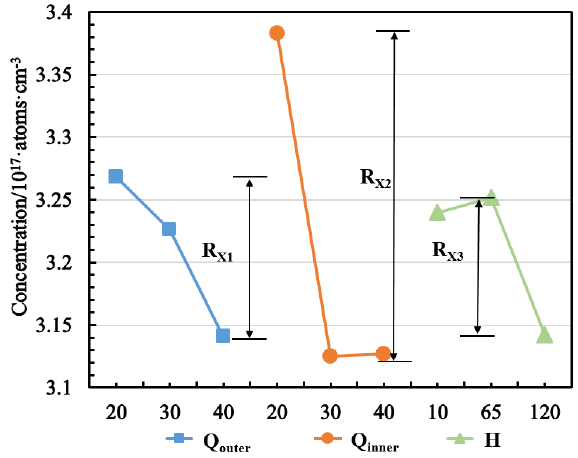
Figure 4. The influence of various levels of factors on O impurity indicators.